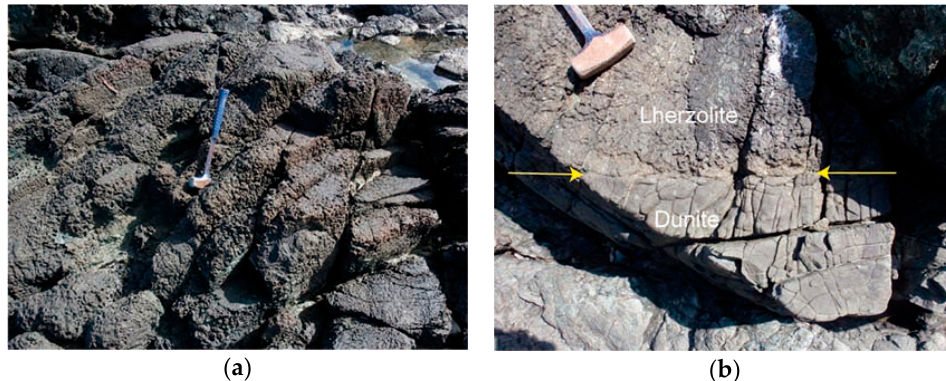
Figure 3. Dunite is easily distinguished from the host lherzolite ( a ) (rough surface because of pyroxene porphyroclasts) by smooth weathered surface, ( b ) indicating that mineral mode is abruptly changed from the host peridotite to the dunite pod (yellow arrows).